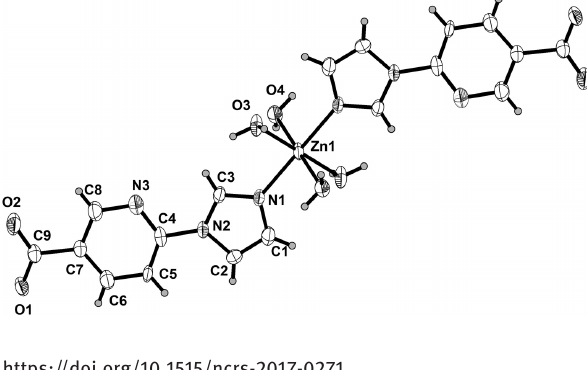
Table 2: Fractional atomic coordinates and isotropic or equivalent isotropic displacement parameters (Å 2